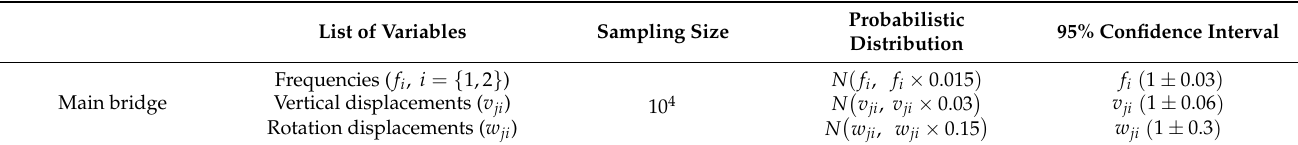
Table 4. Measurement input variables.